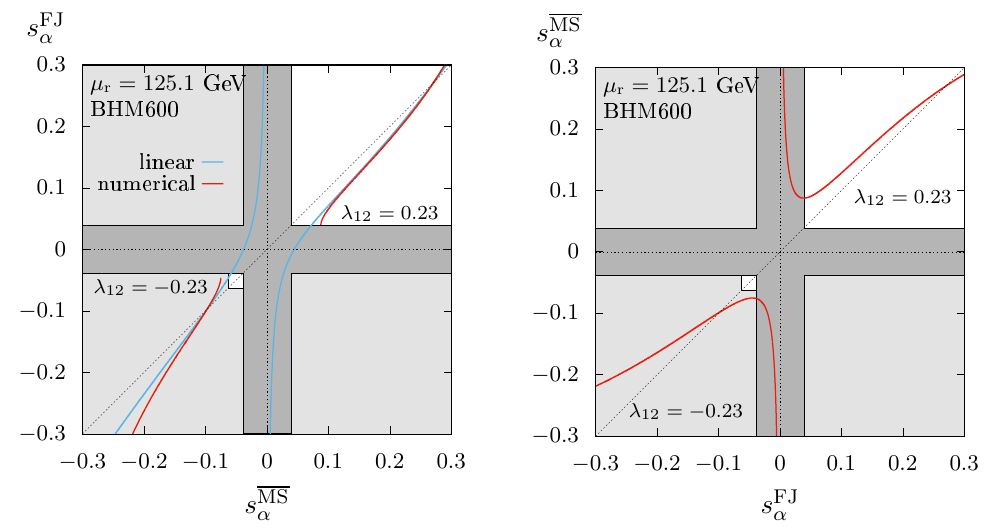
Figure 15 . Conversion of the input parameter s (cid:11) between the MS and the FJ schemes. The heavy Higgs-boson mass M H is (cid:12)xed according to benchmark scenario BHM600. Red and blue lines correspond, respectively, to the complete and linearized solutions of the matching condition